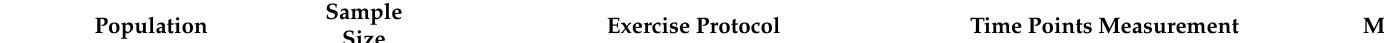
Table 3. Summary of the studies evaluating the effect of exercise on serum hepcidin and IL-6